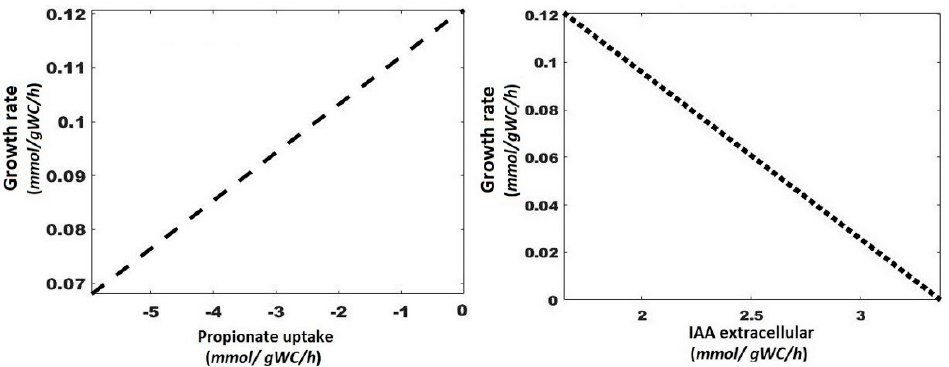
Figure 6. Simple robustness analysis of IAA formation metabolism and propionate consumption as a function of growth rate. Negative values of the propionate uptake are indicating that this substrate is consumed.